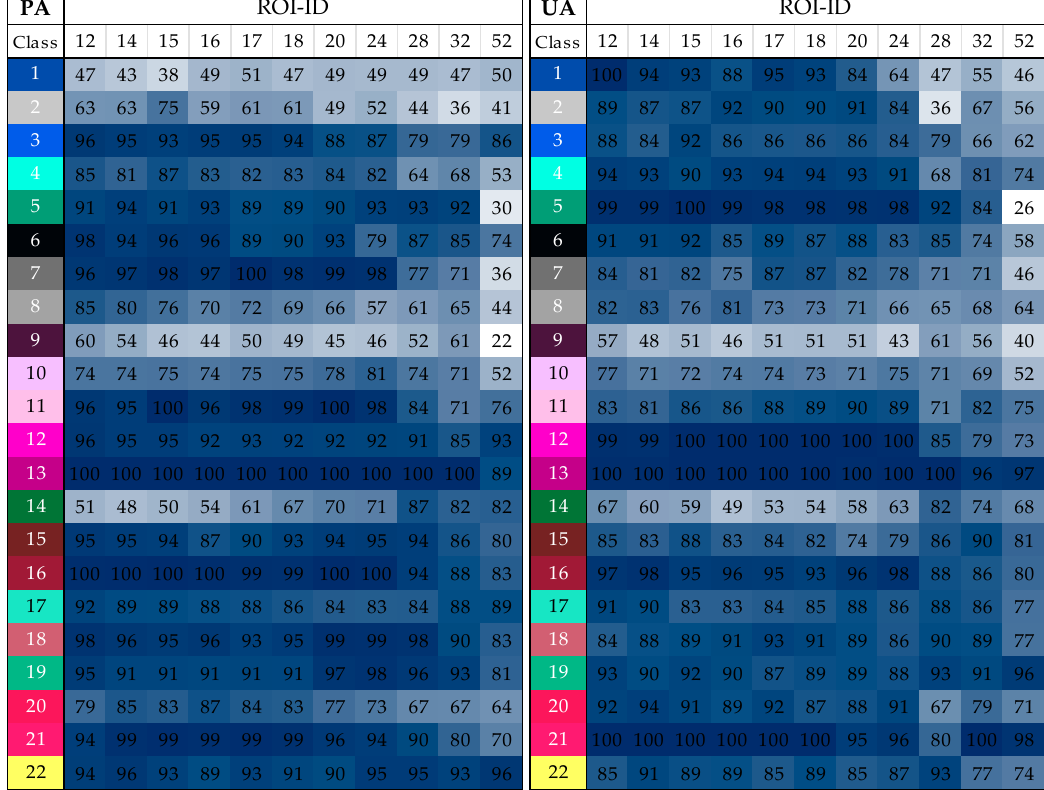
Figure 6. Producer’s accuracy (PA) and user’s accuracy (UA) of the 22 classes by Random Forest and ROI size. PA and UA values are colored in blue as a function of their magnitude (darker colors represent higher values). The class columns are colored as in Table 1.